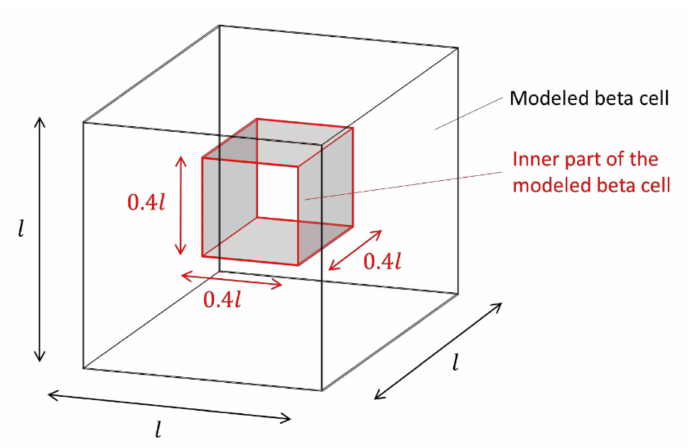
Figure 8. definition of the inner part of the modeled beta